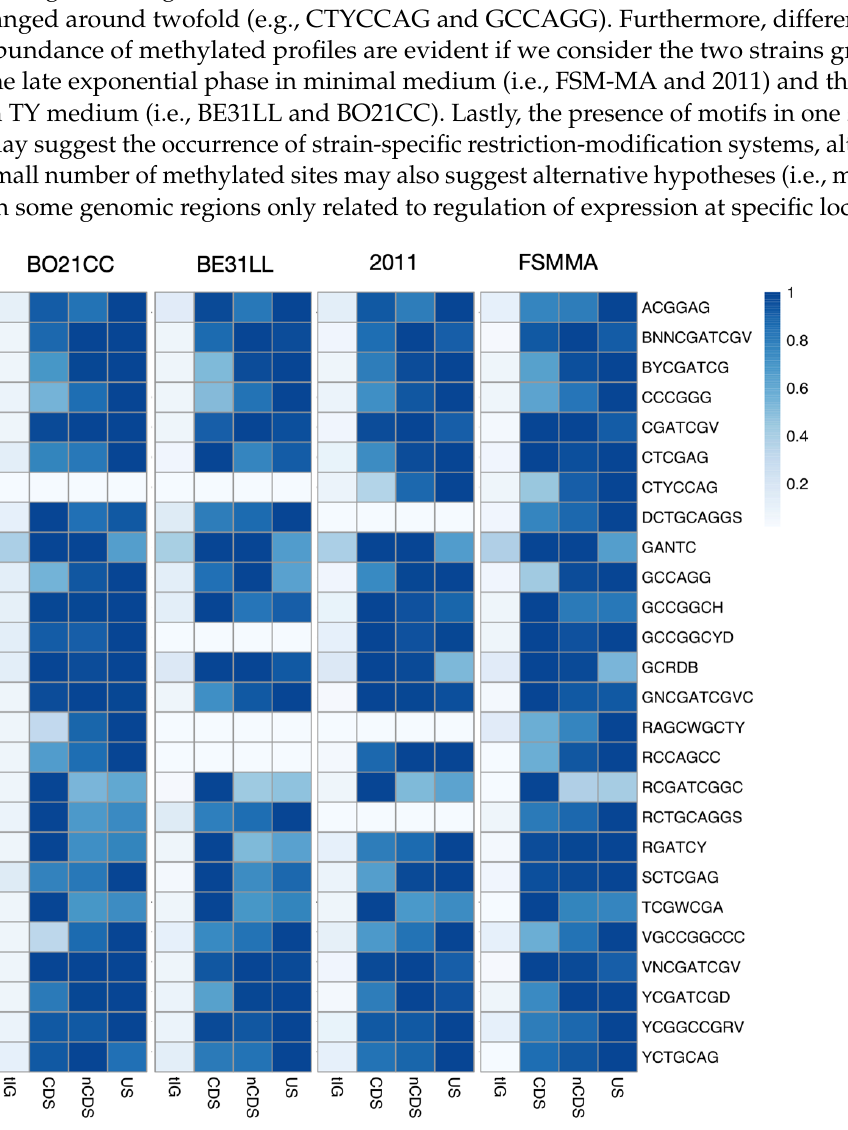
Figure 1. Heatmap representing methylated motif’s occurrences scaled as ratio to the max.